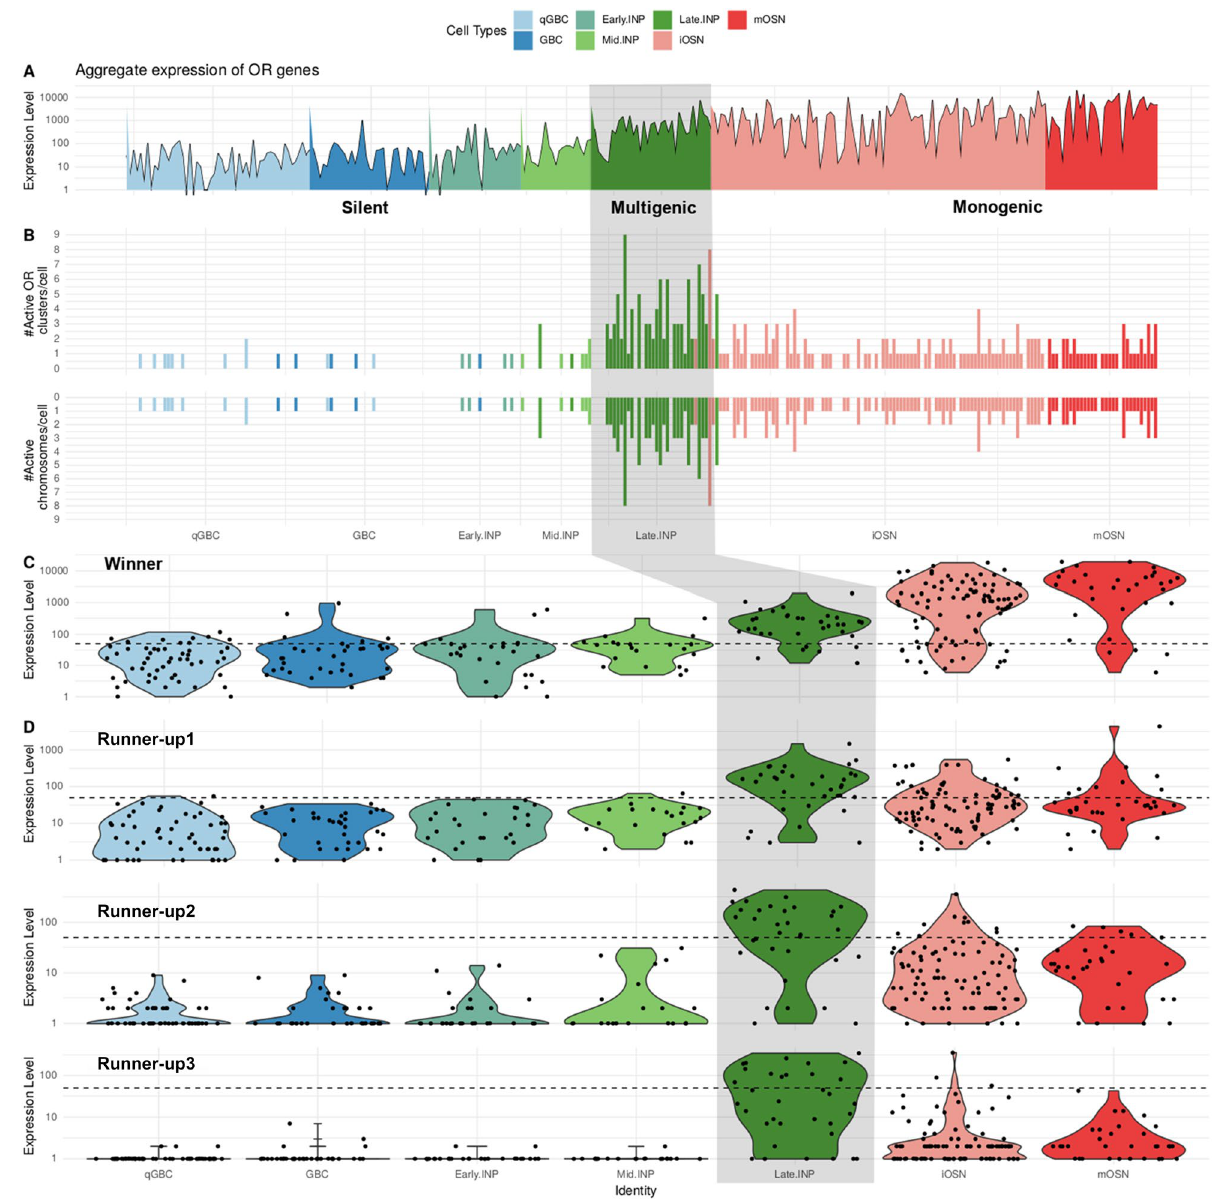
Figure 2. OR expression dynamics along neuronal lineage. ( A ) Aggregate expression (normalized pseudocounts) of all OR genes for each cell. Cells are sorted according to pseudotime and colored according to cell type. ( B ) Number of active OR clusters and chromosomes per cell, sorted by pseudotime. Since active clusters can be located on the same chromosome, the number of active chromosomes is less or equal to the number of active clusters per cell (e.g., in Late.INP all cells with 2 active clusters have also 2 active chromosomes, but in iOSN and mOSN cells with a single active chromosome may have 2 active clusters). Note that three cells classified as iOSN according to our marker genes are placed slightly before some cells classified as Late.INP in the pseudotime ordering. ( C ) Expression of the OR gene with the highest expression level in each cell (“winner”). For each stage of the neuronal lineage, we show the distribution of the corresponding expression values (pseudocounts) as a violin plot. ( D ) Using the same representation as in C, the expression of the OR gene with second, third and fourth highest expression (“runnersup” 1–3) in each cell is shown in the top, middle, and bottom row, respectively. Note that the y-axis is in log scale, and that the scale of the winner expression is on average one to two orders of magnitude higher than that of the runners-up. The dotted horizontal line in ( C ) and ( D ) marks an expression level of 50 normalized